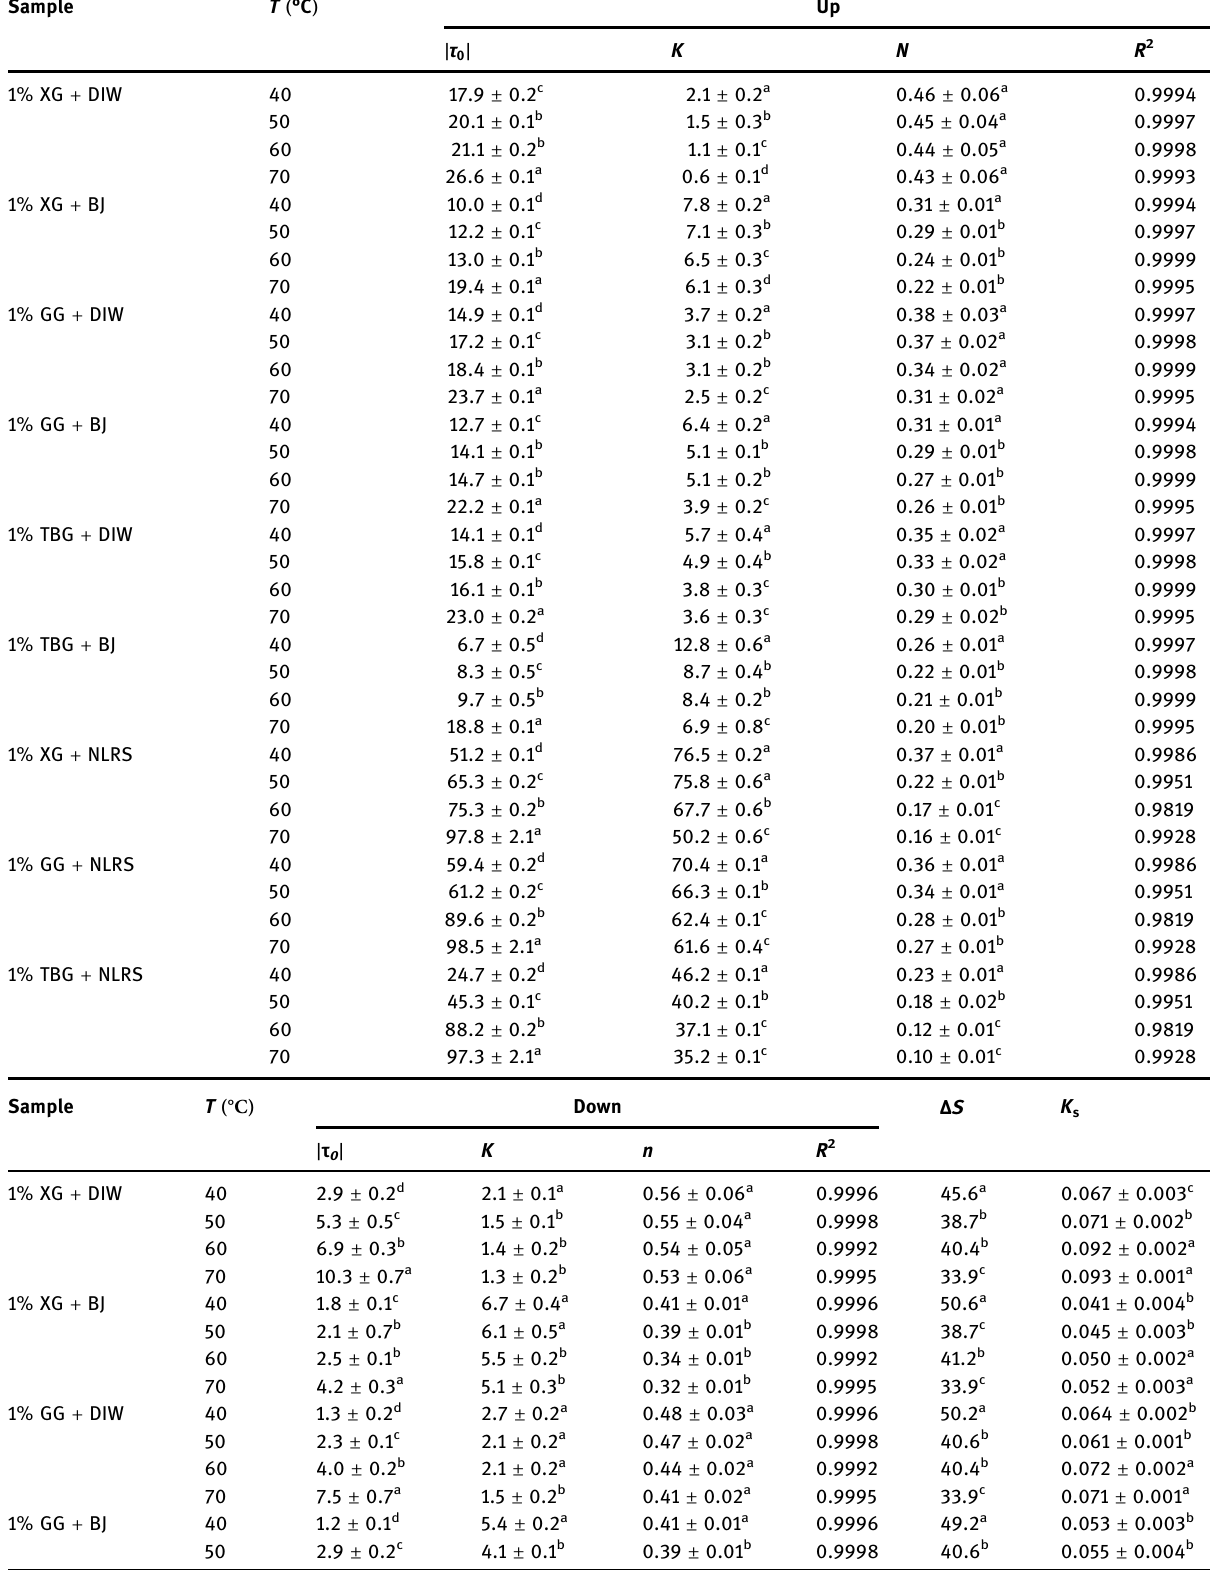
Table 5: E ff ect of temperature on Herschel – Bulkley parameters and thixotropic destruction coe ffi cient